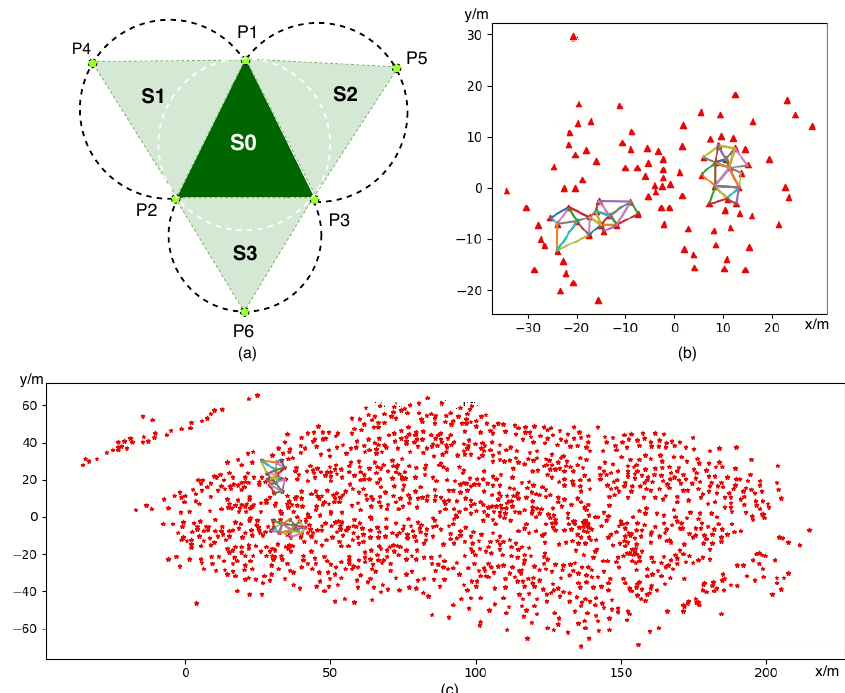
Figure 6. ( a ) The target triangle S 0 with its neighbors S i , i = 1.3. ( b ) The all similar triangles found in the local trunk map, ( c ) the corresponding triangles found in global trunk